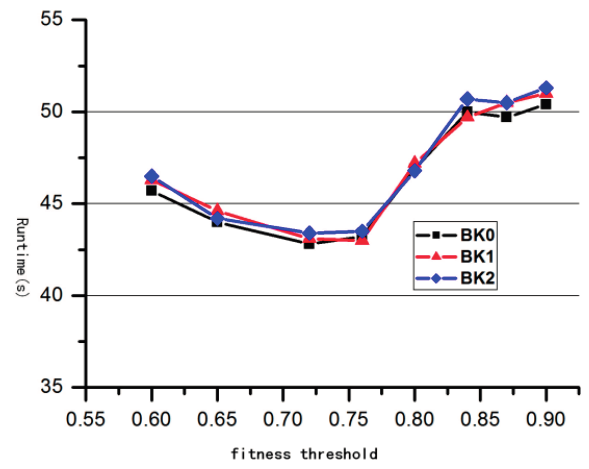
Figure 6. The learning runtime under the different fitness